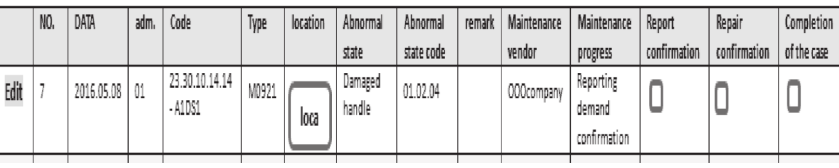
Figure 6: Request for repair from the web